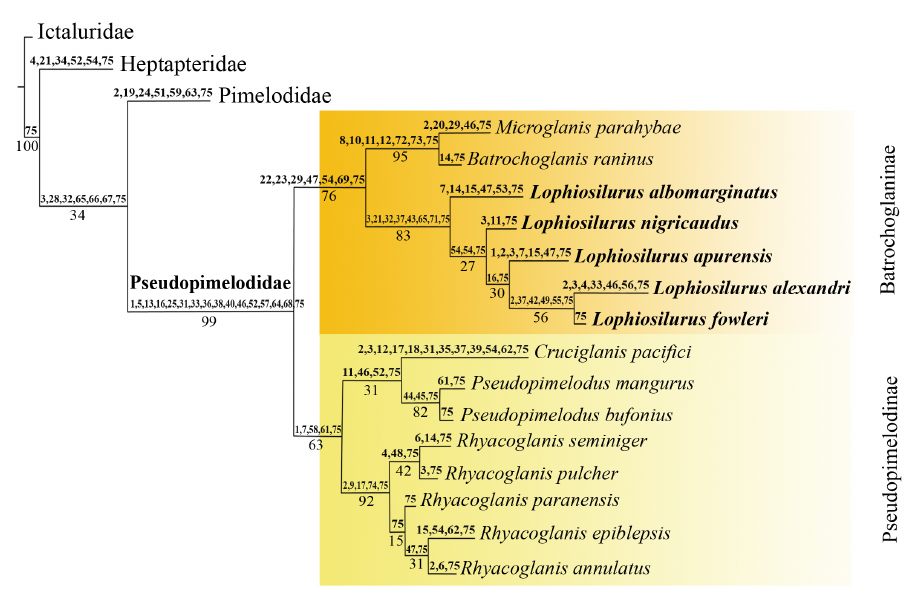
FIGURE 12 | Resampled tree (CI = 63; RI = 76; length (best score) = 148.87) of Pseudopimelodidae derived from combined 75 characters matrix data set, with synapomorphies above and support values (symmetric resampling) under the branches. Pseudopimelodidae subfamilies names according to Silva et al .